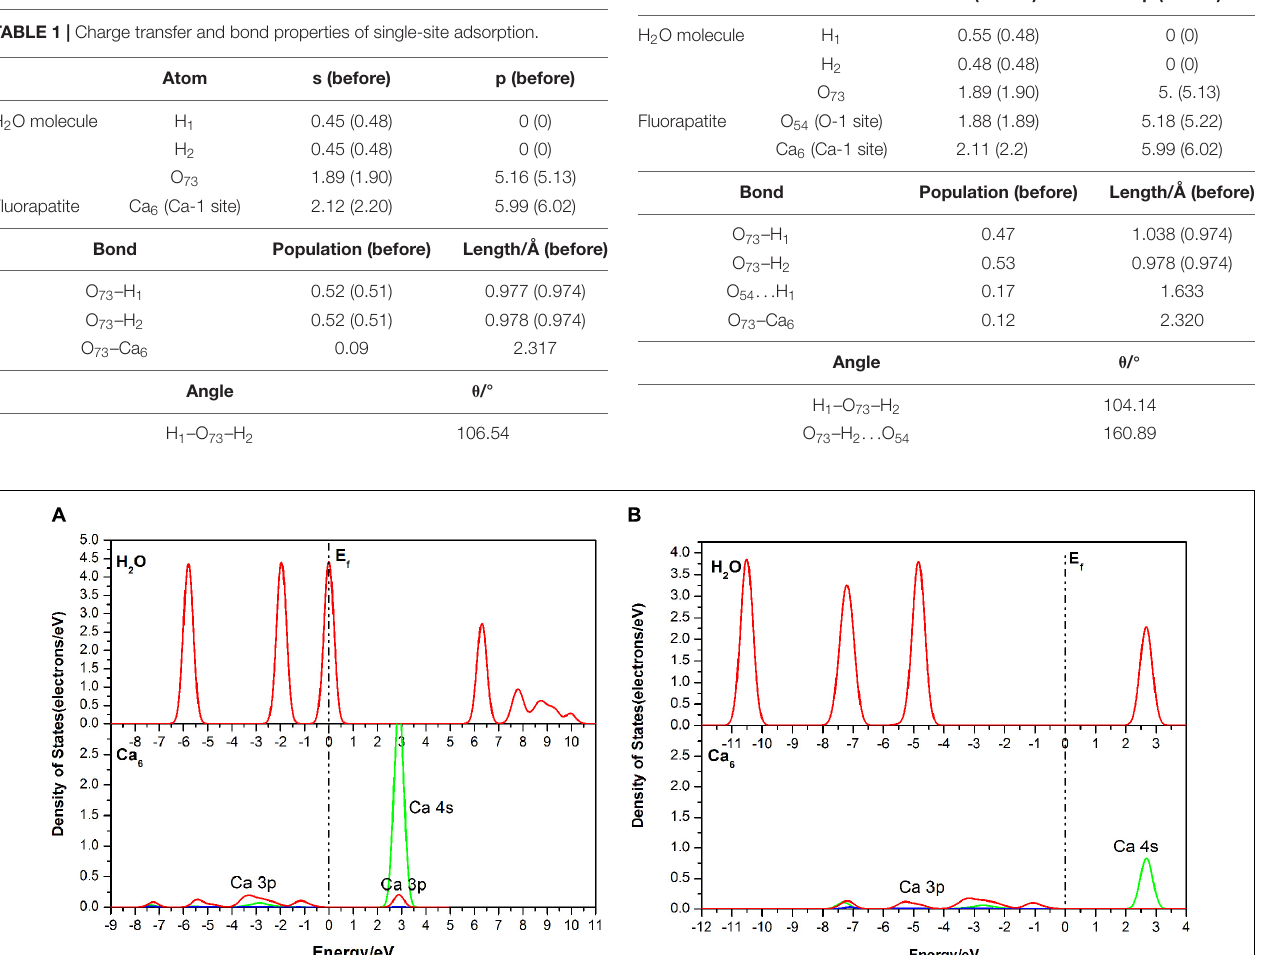
FIGURE 5 | Densities of states (DOS) of the corresponding atoms in the single-site adsorption: (A) before adsorption; (B) after adsorption.